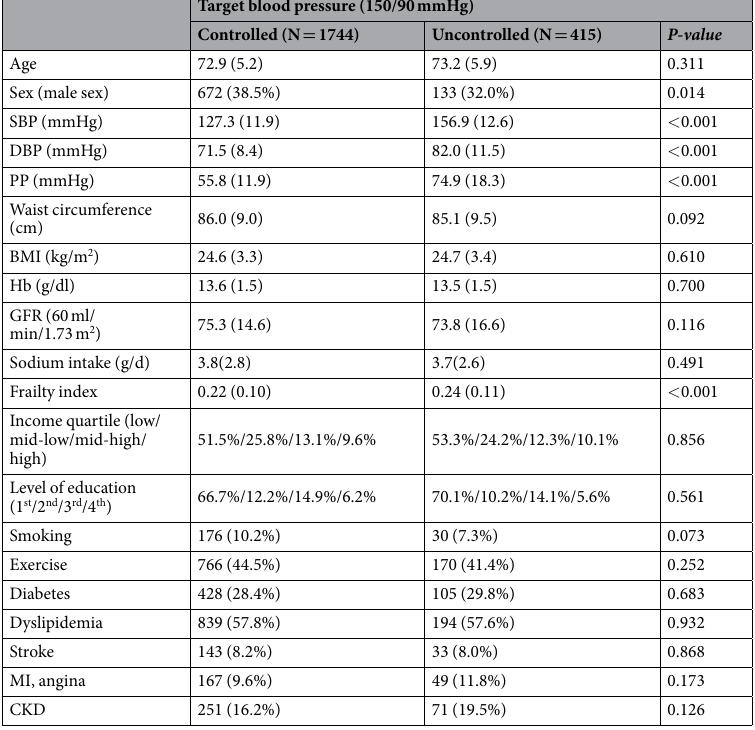
Table 2. Univariate analysis: factors associated with blood pressure control (target blood pressure: 150/90 mmHg) SBP: systolic blood pressure, DBP: diastolic blood pressure, PP: pulse pressure, BMI: body mass index, Hb: hemoglobin, GFR: glomerular filtration rate, MI: myocardial infarction, CKD: chronic kidney disease. Income quartile: household income/month, Low: household income/month < 650 US dollars, Mid-low: 650 US dollars ≤ household income/month < 1300 US dollars, Mid-high: 1300 US dollars ≤ household income/month < 2100 US dollars, High: household income/month ≥ 2100 US dollars. Level of education: 1 st : elementary school or lower, 2 nd : middle school, 3 rd : high school, 4 th : college or higher. Dyslipidemia: either hypercholesterolemia, hypertriglyceridemia, low HDL-cholesterolemia, or a combination. (Hypercholesterolemia: 12 h-fasting total cholesterol ≥ 6.22 mmol/L (240 mg/dL) or taking hypercholesterolemia medications, Hypertriglyceridemia: 12 h-fasting triglyceride ≥ 2.27 mmol/L (200